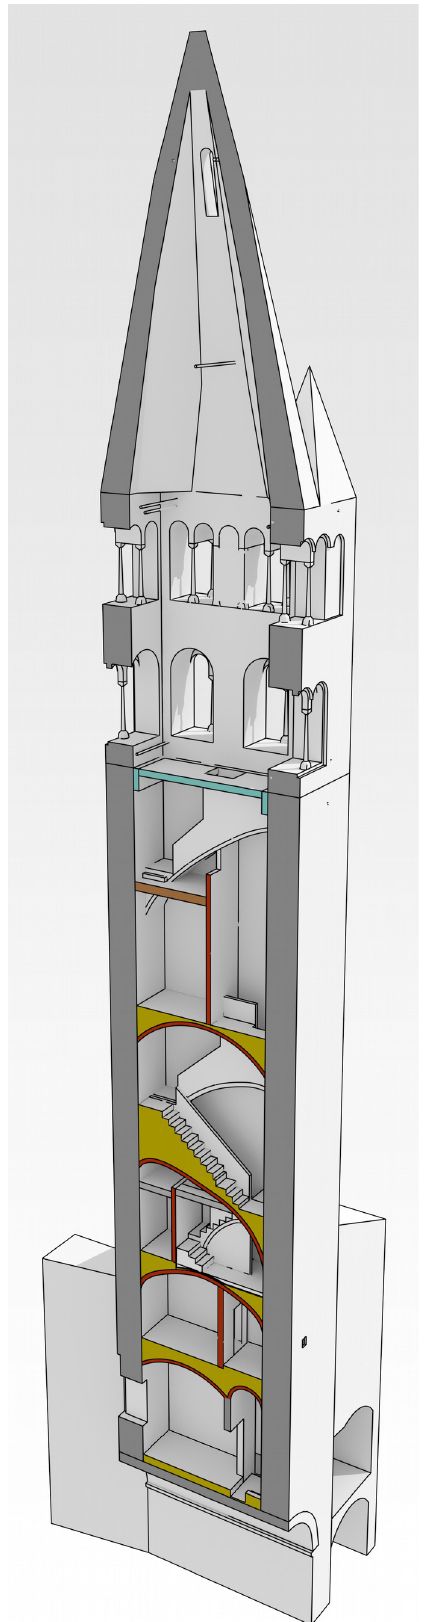
Figure 4. Retopology of the bell tower and schematization of the materials used: grey=stone; red=brick; yellow=filling; brown=wood; cyan=concrete (B. Di